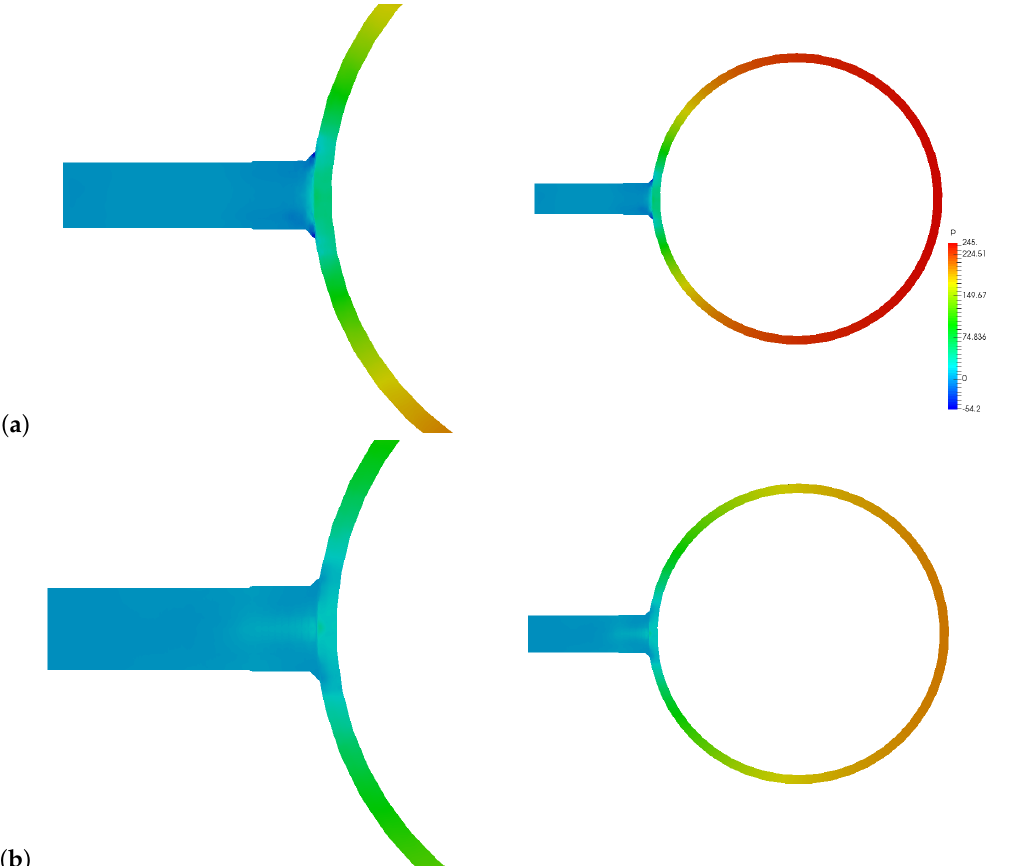
Figure 7. Specific pressure distribution for grooves 1 ( a ) and 2 ( b ) for position R12 with detail of junction with outlet port. Units of specific pressure are